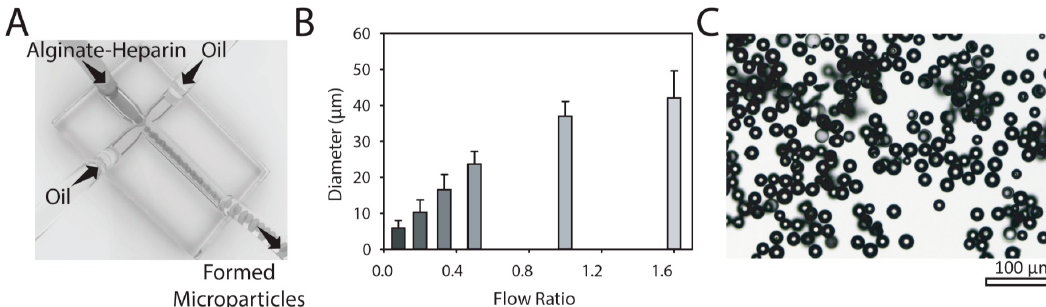
Figure 1. Formation of alginate-based microparticles. ( A ) Schematic of microfluidics platform used to control formation of microparticles. Hydrophobic coated glass microfluidic droplet junction chip with 100 µm diameter used in this study. ( B ) Controlling flow rates was used to tune the size of alginate-based microparticles. The presented data are expressed as average ± SD (number of independent experiments; n = 3; for each independent experiment more than 40 microparticles were measured). ( C ) Bright-field image of calcium crosslinked alginate-heparin microparticles at water phase / oil phase flow ratio of 0.33 (oil flow rate: 12 µ L / min; water flow rate: 4 µ L /